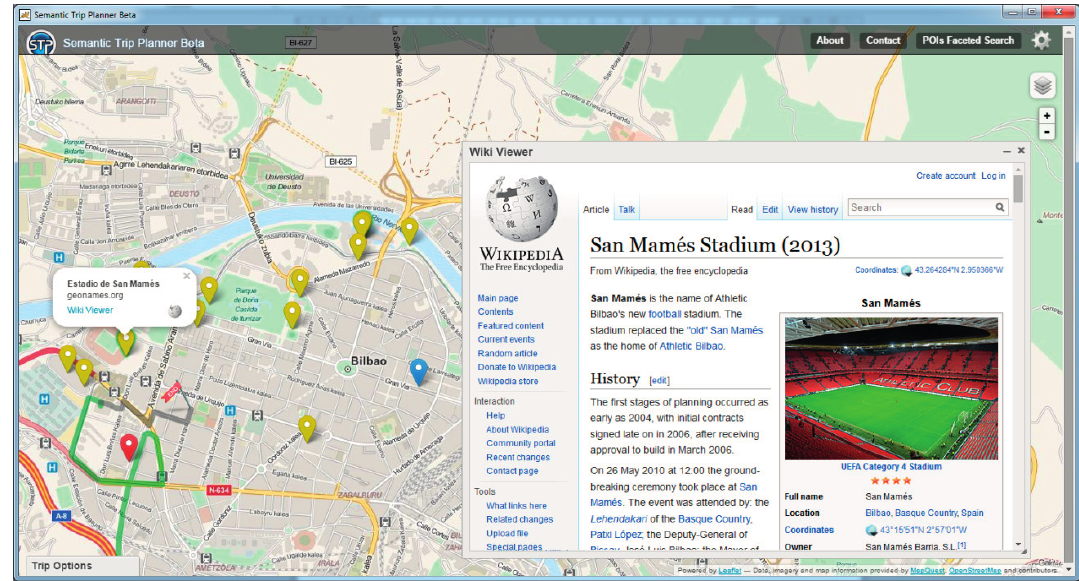
Figure 13. STP. Extended information (Wikipedia) about